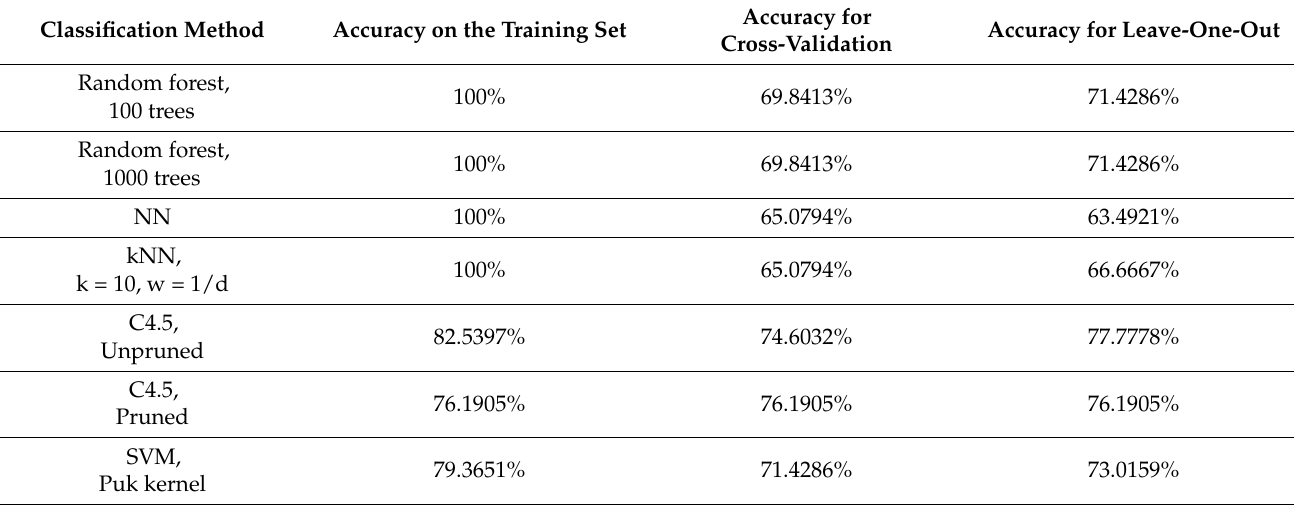
Table 16. Classification results for all records in the dataset.